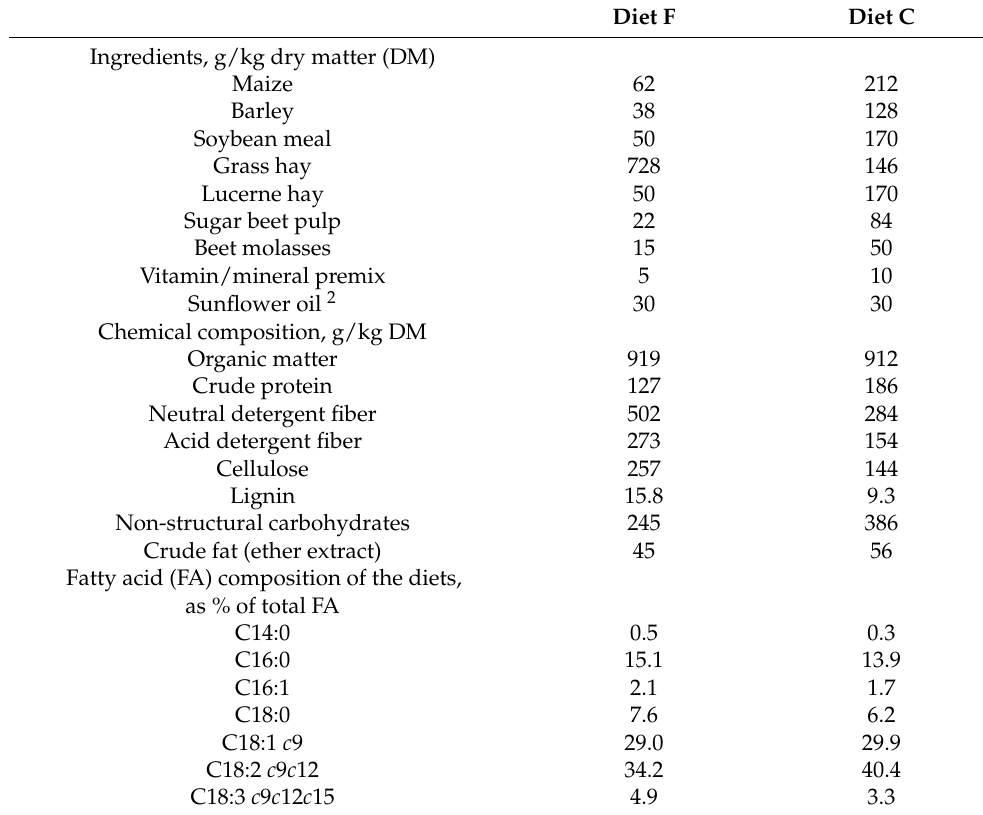
Table 1. Ingredients and chemical composition of experimental diets 1